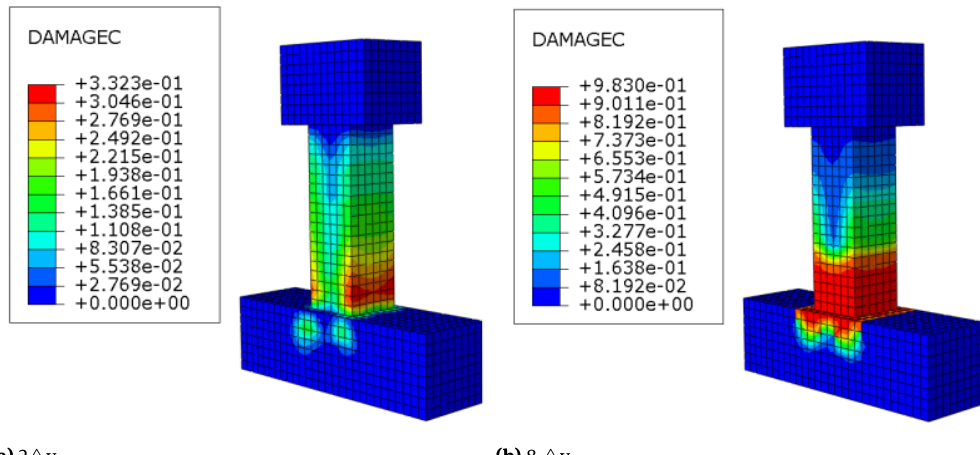
Figure 11: Nephograms of Compression Damage of